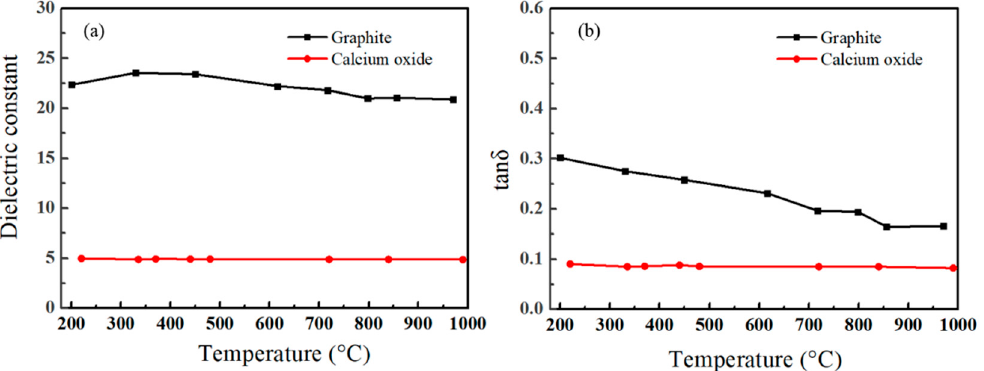
Figure 8. The dielectric constant ( a ) and tan δ ( b ) of graphite and calcium oxide.